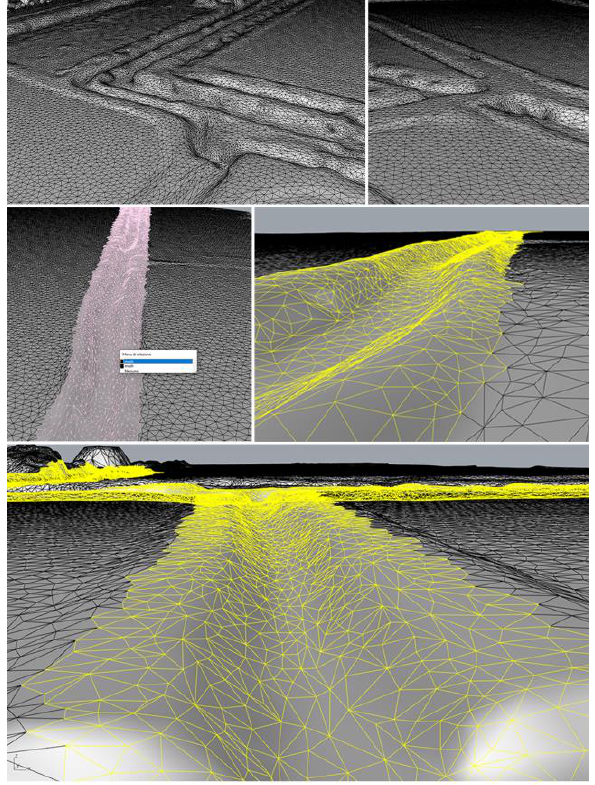
Figure 4 . The mesh of the terrain and irrigation canals is divided into layers, which can be selected separately.